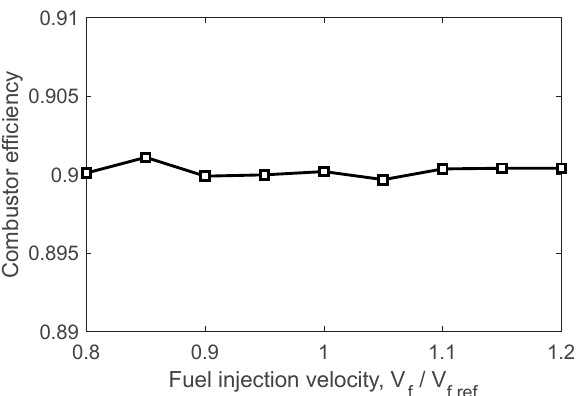
Figure 17. Effect of the fuel injection velocity on the combustion efficiency. Similarly to the previous study, the total temperature distribution at the outlet is ana- lyzed. Figure 18 shows the total temperature distribution in the circumferential direction at the combustor outlet mid-span for different values of fuel injection velocity. No significant change in temperature can be observed with different fuel injection velocities. The curves almost lay on top of each other. This confirms the observation form the combustion effi- ciency calculation (Figure 17), that is, the fuel injection velocity has no significant impact on the combustion efficiency.